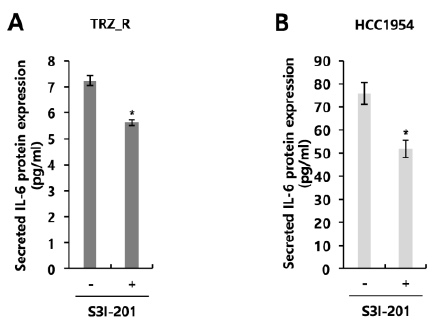
Figure 5. S3I-201 (STAT3 inhibitor) inhibits IL-6 expression in TRZ-resistant breast cancer cells. BT474 TRZ_R and HCC1954 cells were treated with 20 µ M S3I-201 for 48 h. ( A , B ) Levels of IL-6 protein (in conditioned culture media) were analyzed by ELISA. Data are presented as the mean ± SEM from triplicate measurements (* p <